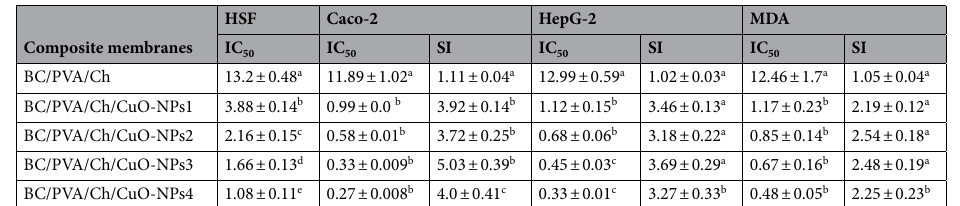
Table 4. IC 50 (mg/mL) and SI values of the prepared BC/PVA/Ch at four CuO-NPs concentrations (0.025, 0.050, 0.075, and 0.100 mg, respectively) against HSF, Caco-2, HepG-2, and MDA cell lines after treatment for 48 h. All IC 50 values were expressed as mean ± standard deviation. Different letters are significantly different in ascending order where a > b > c > d > e within the same column at p < 0.05.